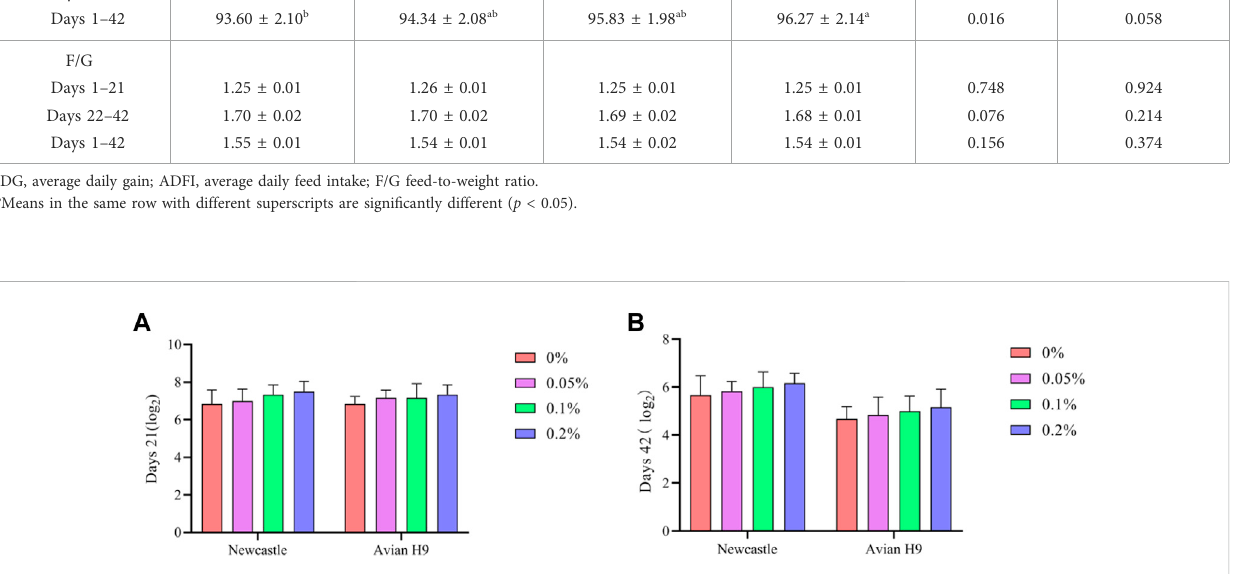
FIGURE 1 Effects of dietary supplementation of Wheat germ, Hops and Grape seed extract mixture (BX) on serum antibody potency in broilers. (A) Newcastle diseaseandAvianin fl uenzaH9antibodypotencyin21 daysbroilersera; (B) NewcastlediseaseandAvianin fl uenzaH9antibodypotencyin42 daysbroiler